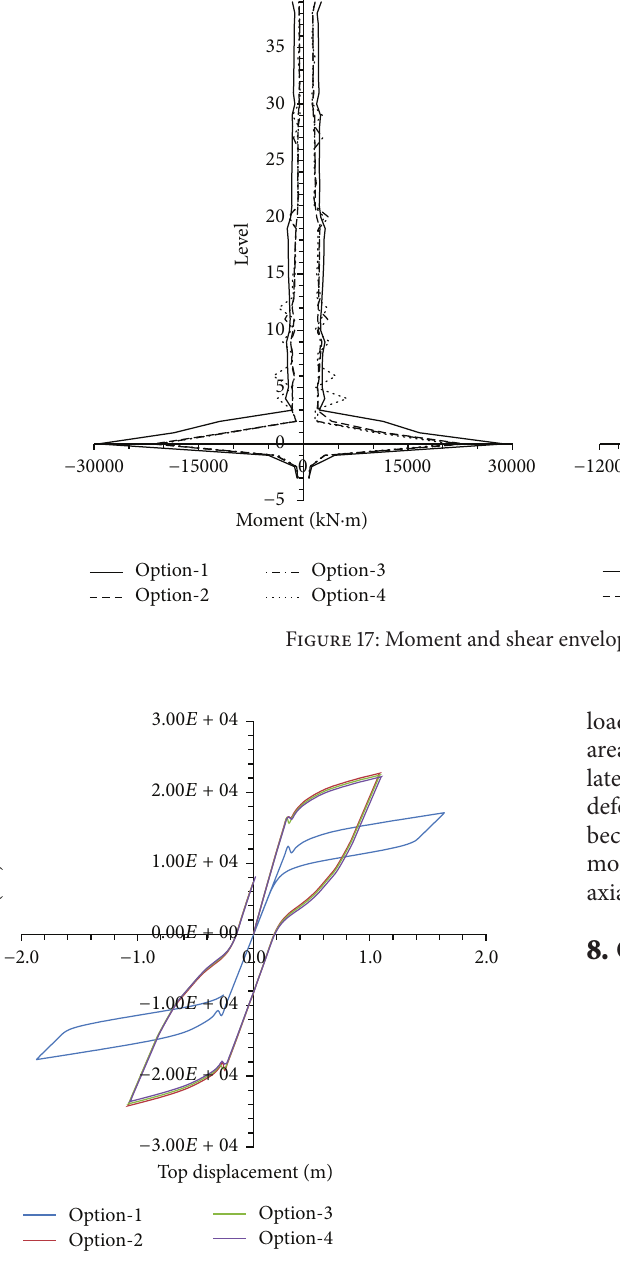
Figure 18: Base shear versus top displacement relationship in first mode load